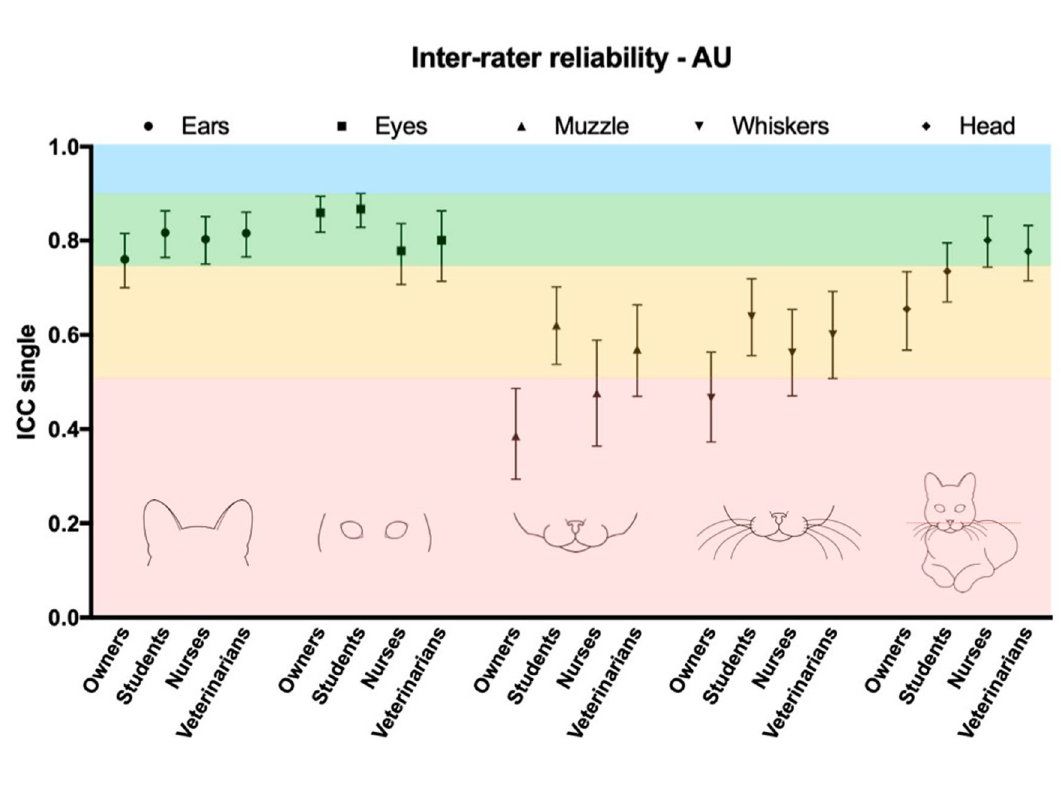
Figure 2. Inter-rater reliability of the action units (AU) composing the Feline Grimace Scale by raters with different degrees of expertise in feline pain assessment. Inter-rater reliability was assessed using a two-way random effects intra-class correlation coefficient (ICC) for absolute agreement (raters: n = 5/group). Estimates for ICC single measures, accompanied by their 95% confidence intervals are presented. Interpretation was as following: ICC < 0.5 = poor (pink), 0.5–0.75 = moderate (yellow), 0.75–0.9 = good (green), and > 0.90 = excellent reliability (blue) 34 . The veterinarian group was composed by individuals with experience in pain